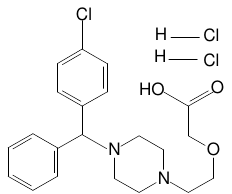
Figure 1 . Chemical structure of levoceterizine